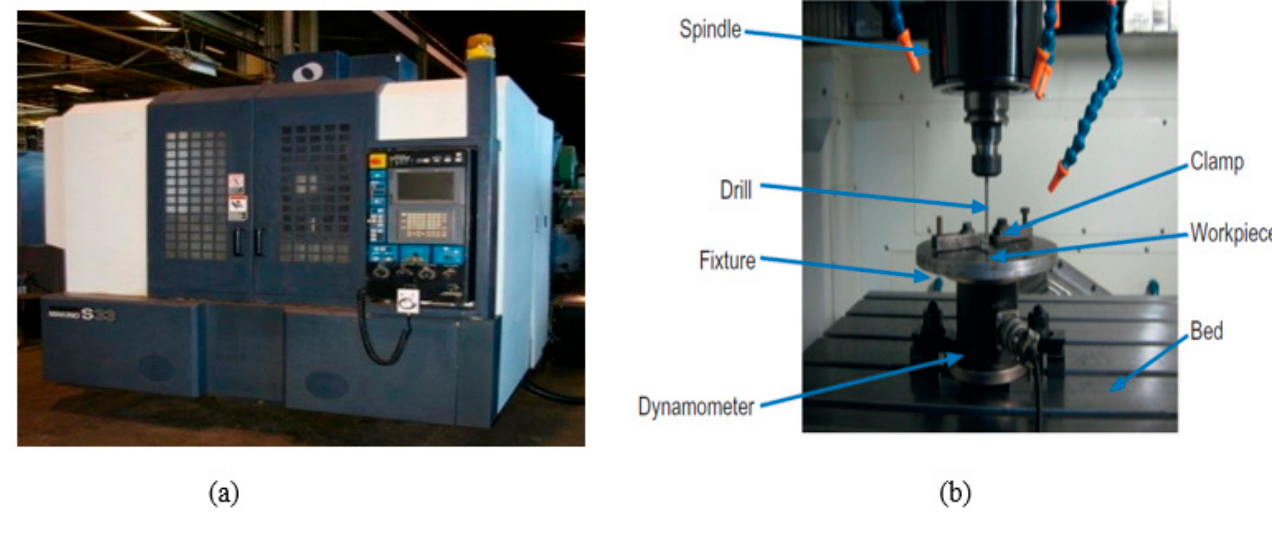
Figure 1. ( a ) Vertical machining center ( b ) Dynamometer arrangement for measuring thrust force [27]. Table 1. Machining